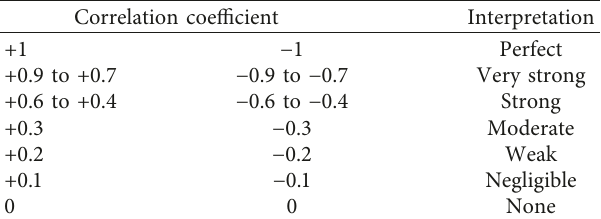
Table 5: Correlation coefficient interpretation. Correlation